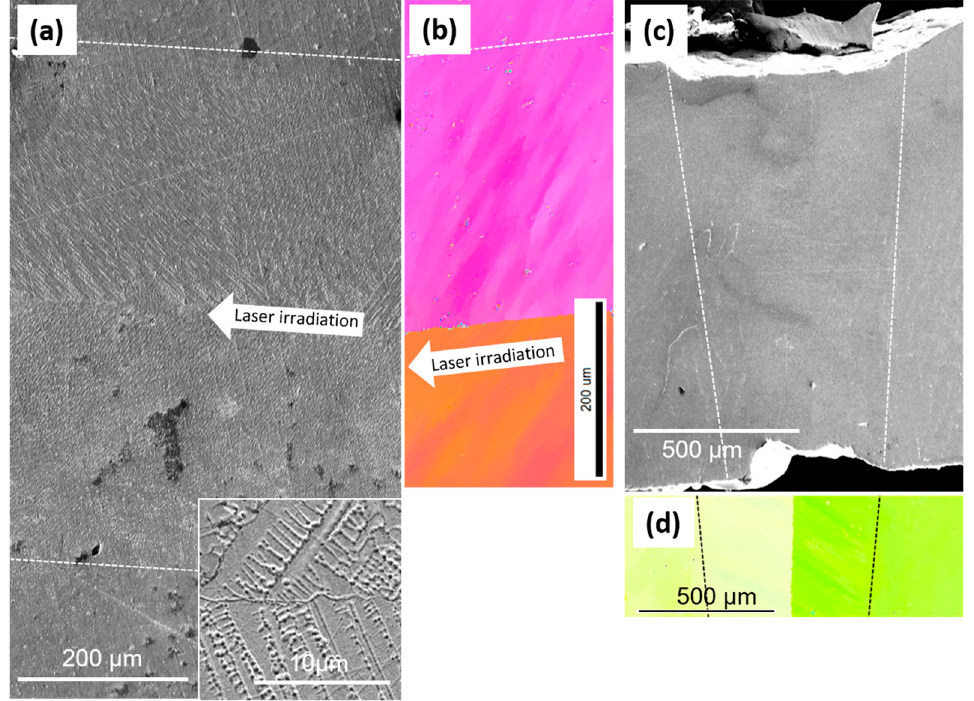
Figure 5. ( a ) Surface FESEM image and ( b ) inverse pole figure (IPF) map obtained via electron backscattered di ff raction (EBSD) analysis of the Ni-9 at.% Al-16 at.% V alloy specimen irradiated linearly by a laser at a scan speed of 100 mm / s. ( c ) Cross-sectional FESEM image ( d ) and IPF map. The dotted lines indicate the interface between the substrate and traces of the molten pool.